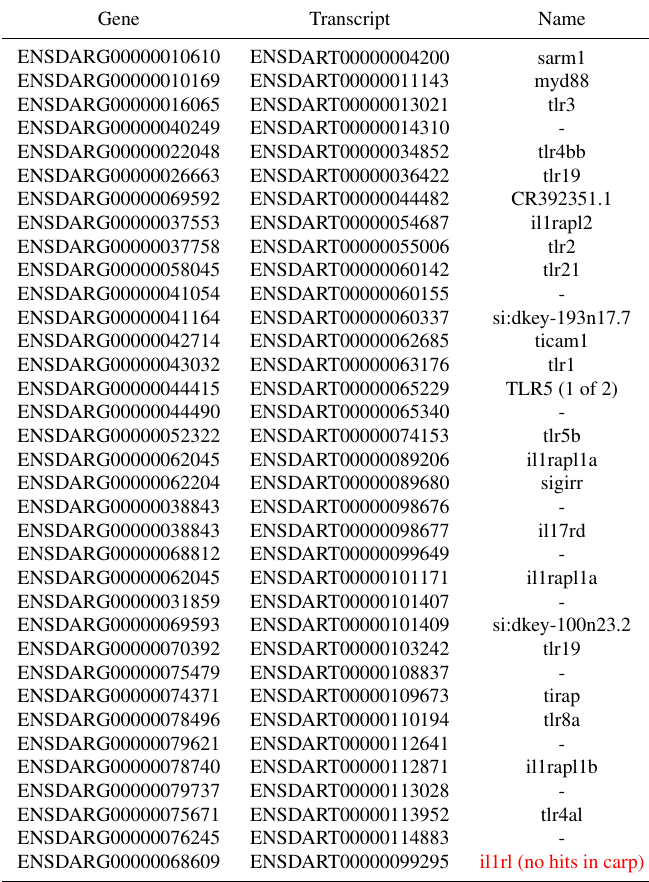
Supplementary Table 2: 35 TIR domain containing peptides in zebrafish. It is found that 34 out of 35 have homologous sequences in carp. We did not find the homologous for i1lr1 gene which is highlighted and showed in the last of the